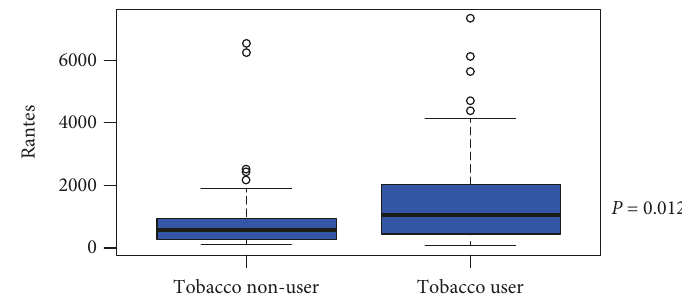
Figure 1: Boxplot of RANTES according to tobacco usage.